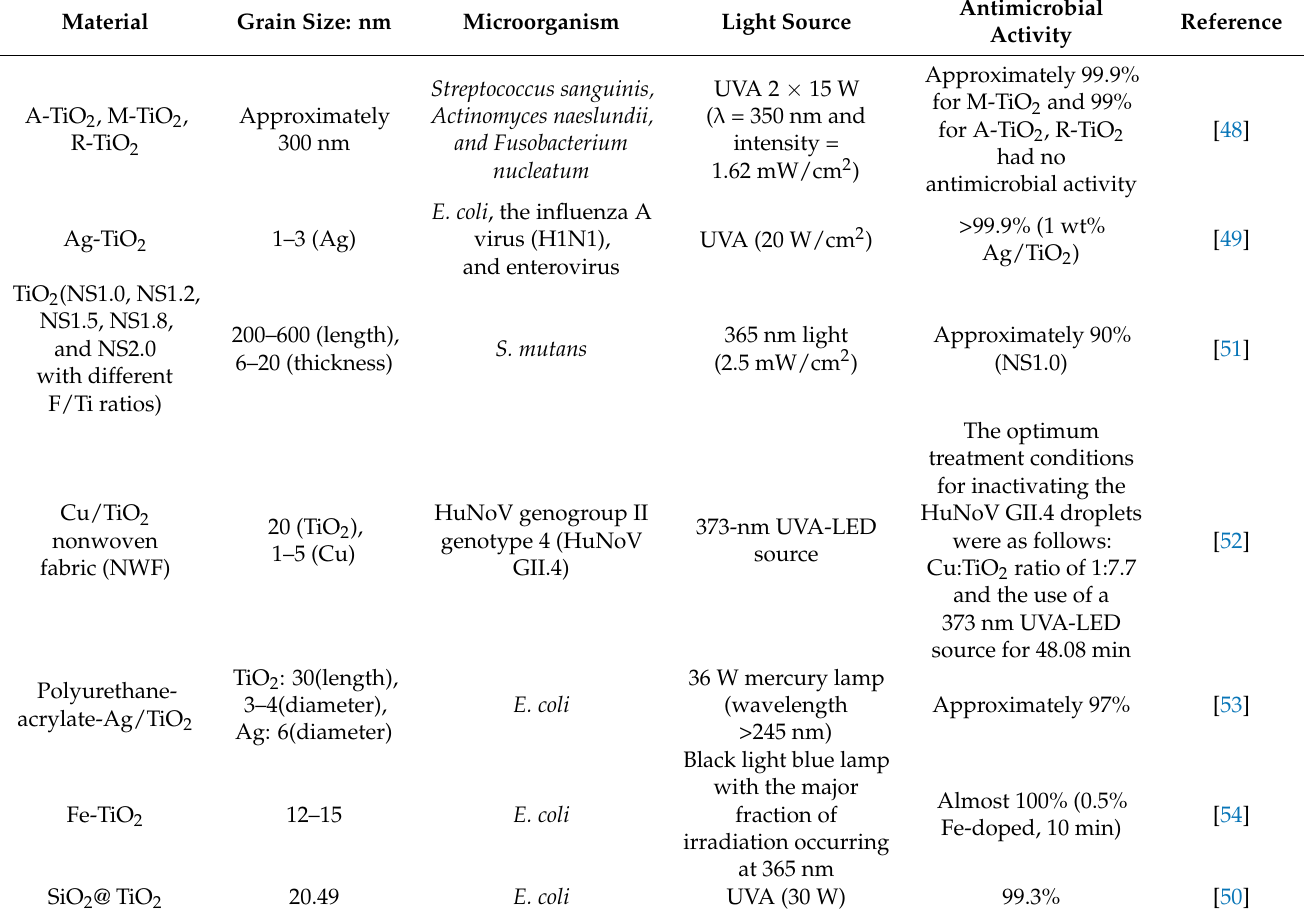
Table 1. Antimicrobial effects of different TiO 2 materials under UV light.